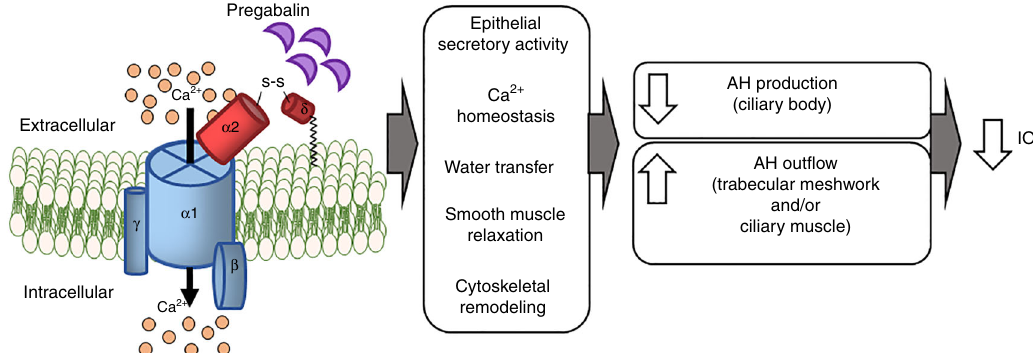
Fig. 6 Proposed mechanism of IOP reduction by pregabalin. We predict that pregabalin binds to CACNA2D1 localized to CB, TM, and/or CM cells. Pregabalin binding causes the α 1 pore to close, leading to a decrease in Ca 2+ in fl ux into cells and a resultant decrease in free cytosolic Ca 2+ . Consequently, the cells relax and aqueous humor in fl ow may be reduced and/or out fl ow may be increased, leading to a reduction